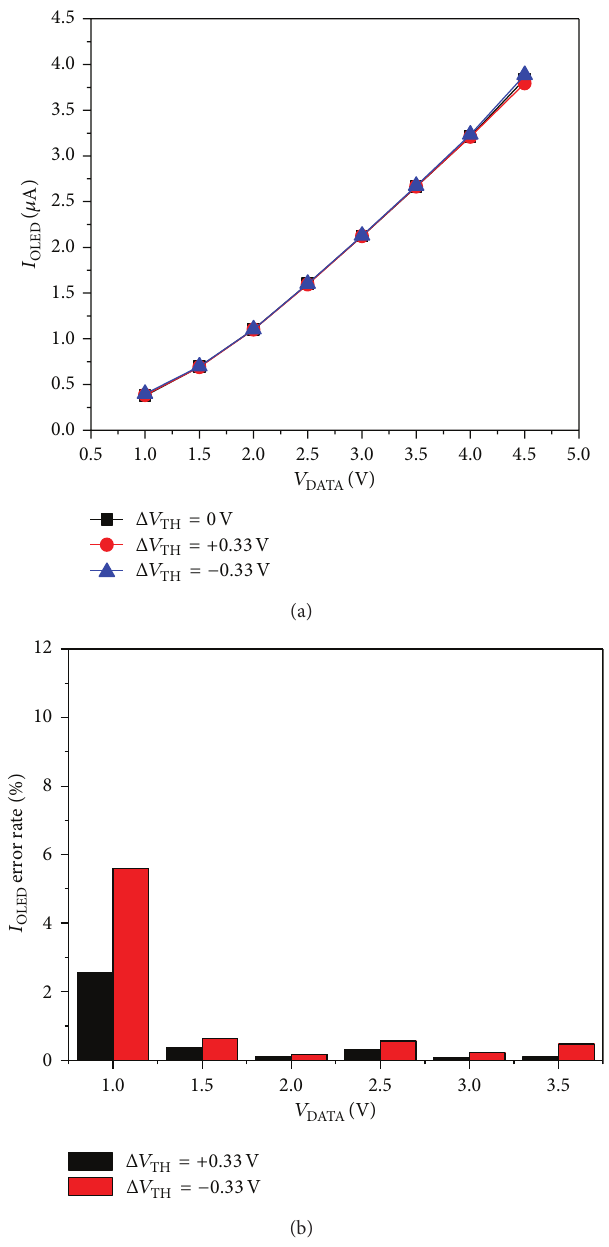
) and (b) 𝐼 error rate when OLED OLED